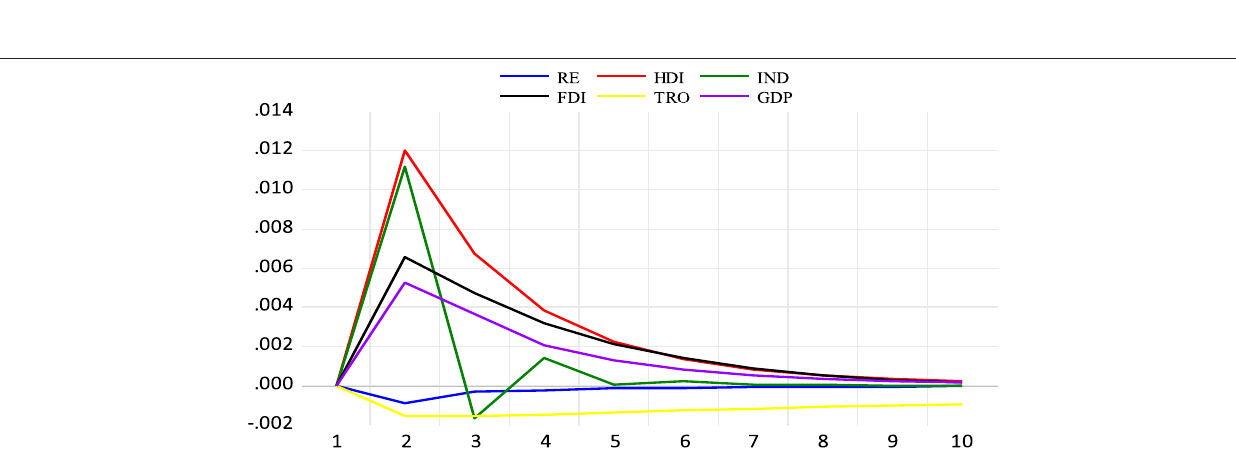
Frontiers in Energy Research |